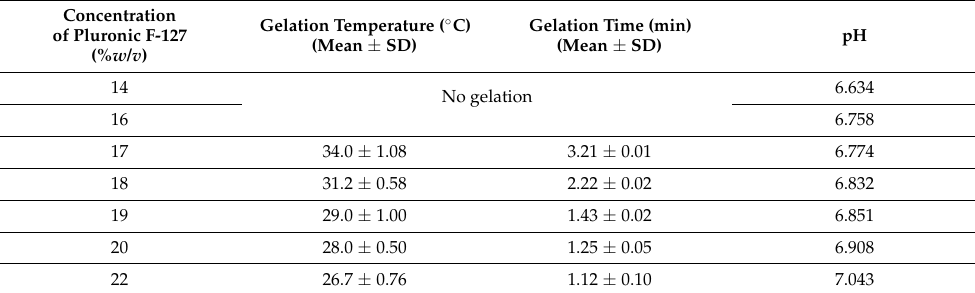
Table 1. Presentation of gelation temperature and gelation time of different Pluronic F-127 aqueous dispersions.